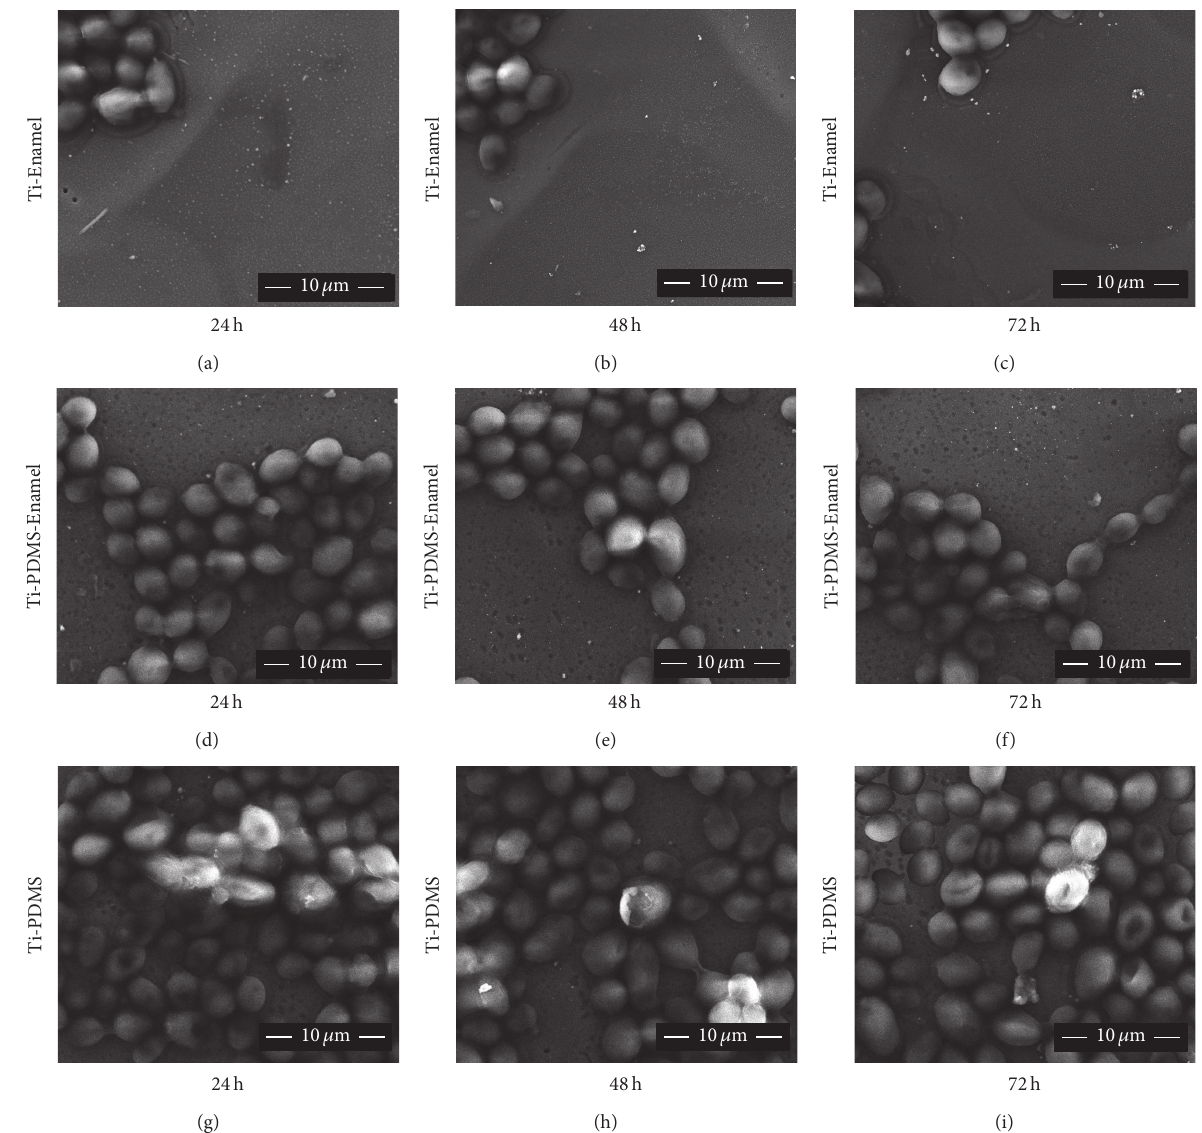
Figure 7: SEM images (10000x) of C. albicans biofilm developed on different substrates at various time intervals (a) C. albicans development on Ti-Enamel layer after 24 h; (b) C. albicans development on Ti-Enamel layer after 48h; (c) C. albicans development on Ti-Enamel composite layer after 72 h; (d) C. albicans development on Ti-PDMS-Enamel layer after 24 h; (e) C. albicans development on Ti-PDMS-Enamel layer after 48 h; (f) C. albicans development on Ti-PDMS-Enamel layer after 72 h; (g) C. albicans development on Ti-PDMS layer after 24 h; (h) C. albicans development on Ti-PDMS layer after 48 h; (i) C. albicans development on Ti-PDM layer after 72